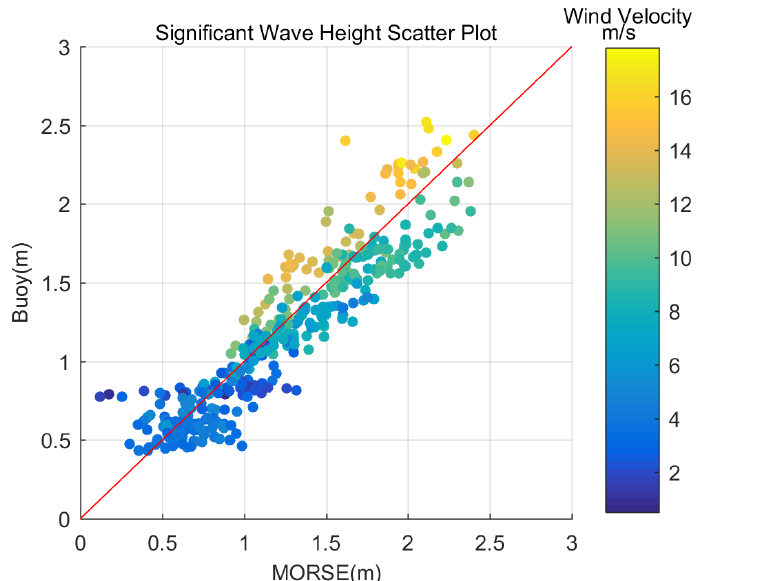
Figure 13. Scatter plot of significant wave height measured by MORSE and the buoy.